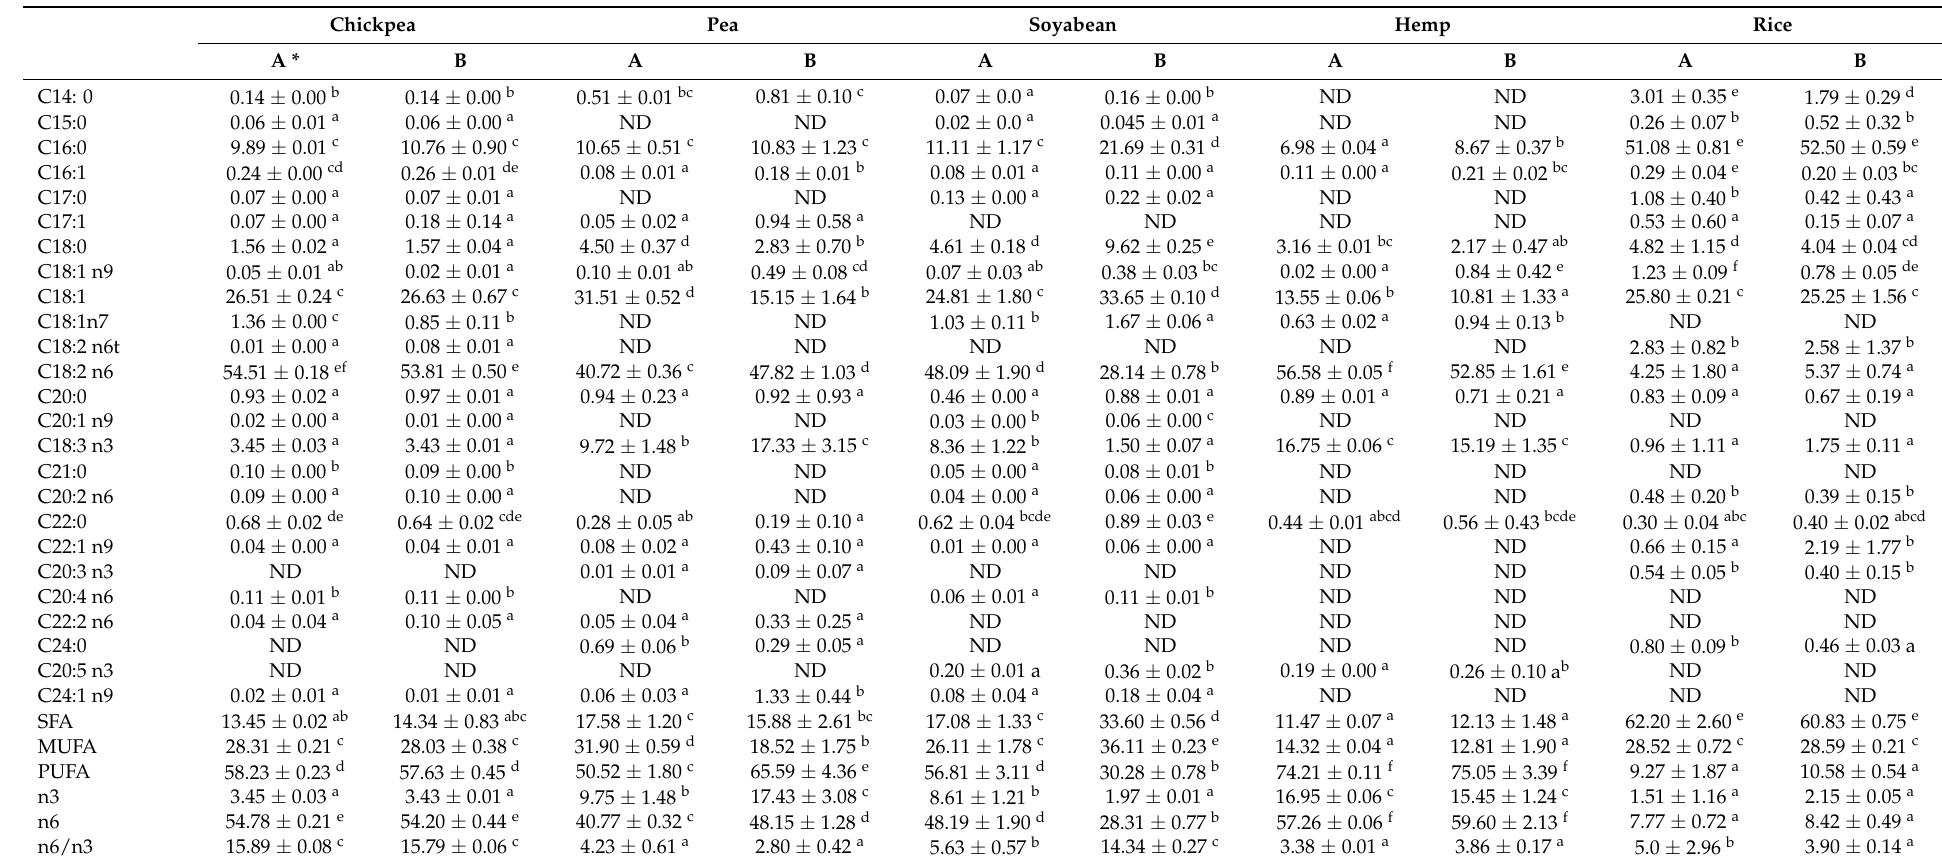
Table 4. The fatty acid composition of different flours (g per 100 g of total fatty acid methyl esters). Data presented as means ± standard deviation from triplicate